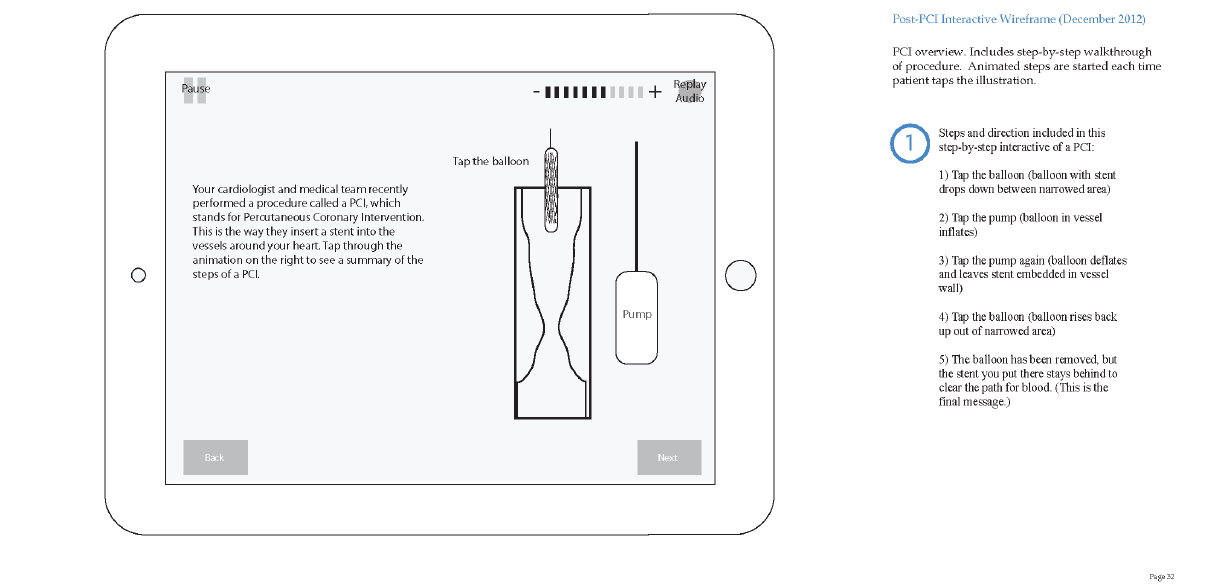
Figure 2. Wireframe number 2 sample page about how a stent works.